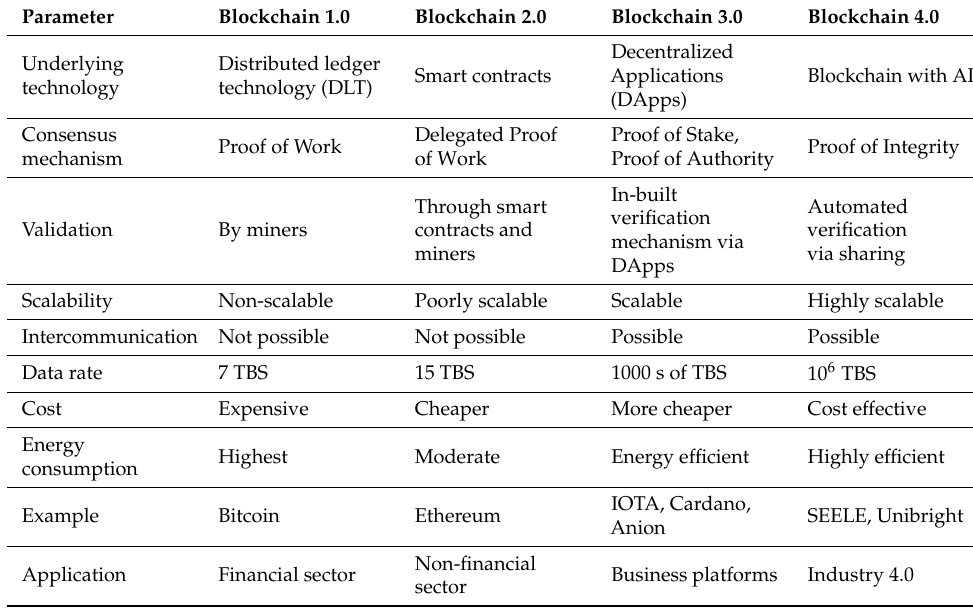
Table 2. Comparative analysis of blockchain